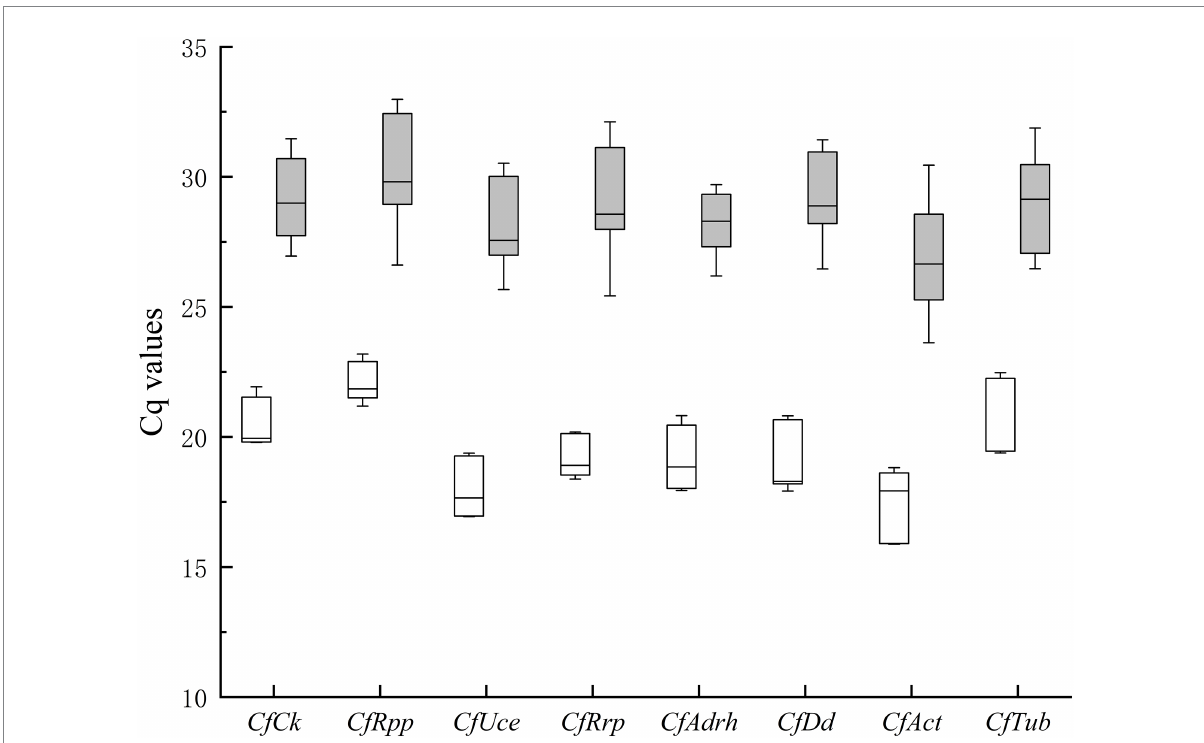
FIGURE 2 Expression levels of candidate housekeeping genes in pathogen and infected leaves. Boxes represent lower and upper quartiles of cycle thresholds range with medians indicated, and whisker caps represent maximum and minimum values. Hatched boxes correspond to pathogen samples (conidia, JS-3 days, 6 days) and white boxes to infected leaves samples (HS-24, 48, and 72 h, HJ-24, 48, and 72 h).